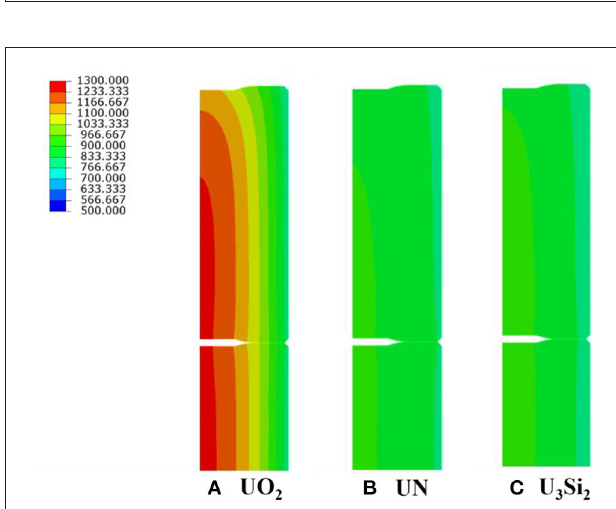
FIGURE 9 | Fuel centerline temperature of three types of cladding with U 3 Si 2